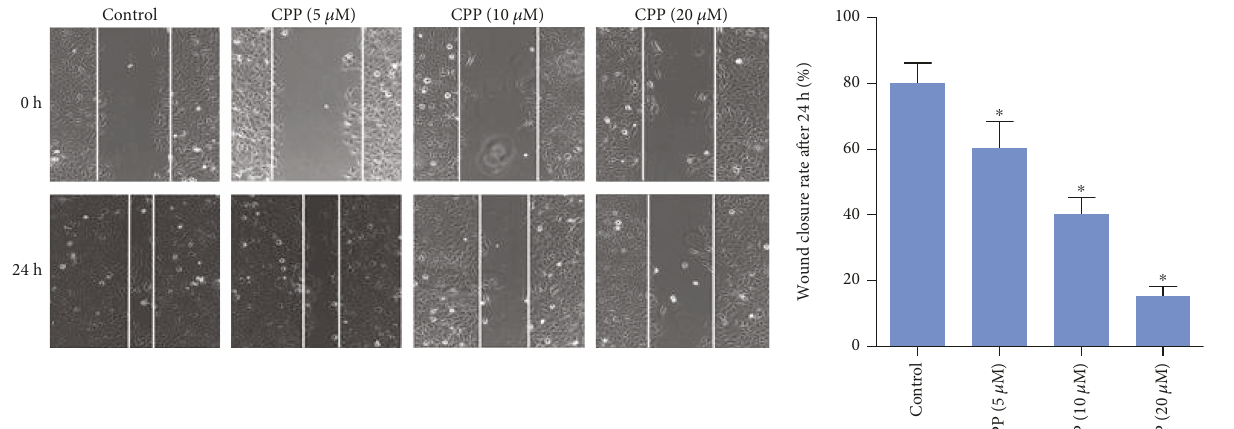
Figure 4: Migration of HepG2 cells. ∗ P < 0 05 versus Control group.